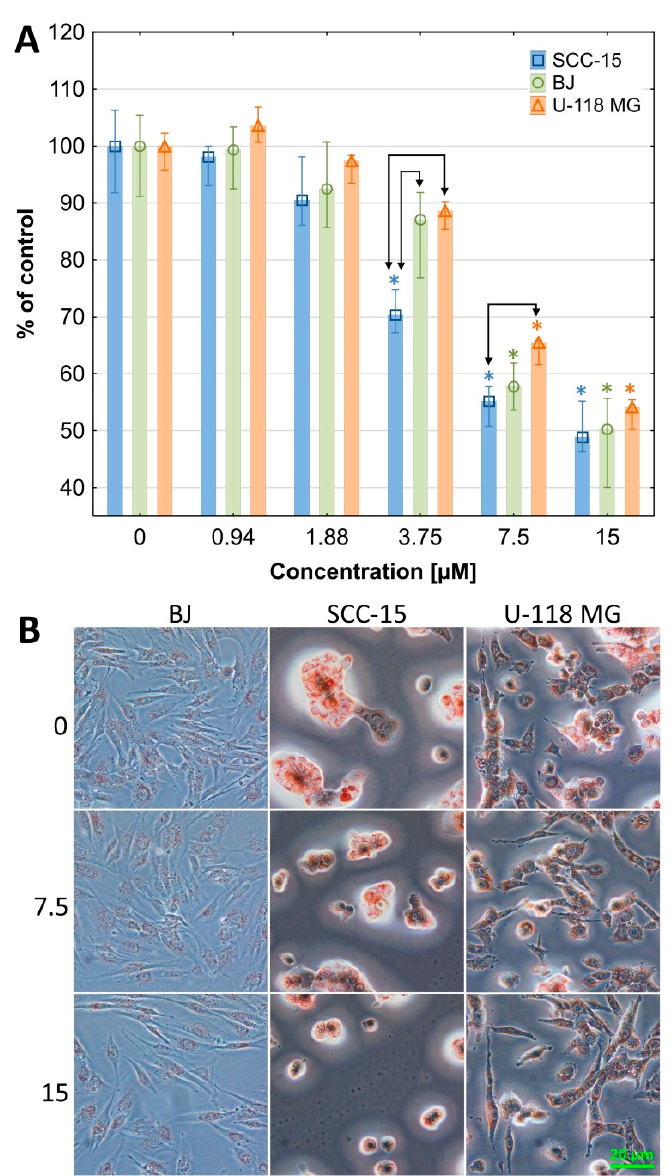
Figure 5. G3 G02N cytotoxicity against BJ, SCC-15 and U-118 MG cells after 24 h treatment. ( A ) Results are presented as median of triplicate assays from three independent experiments, expressed as a % of non-treated controls. The whiskers are the lower (25%) and upper (75%) quartile ranges. * p < 0.05; Kruskal–Wallis test (against non-treated respective control). ( B ) Changes in cell morphology after 24 h treatment with G3 G02N and after 1 h incubation with neutral red. Red vesicles are lysosomes containing dye. Numbers indicate a micromolar concentration of G3 G0N . Images were obtained with a contrast phase microscope (Olympus IX-83).